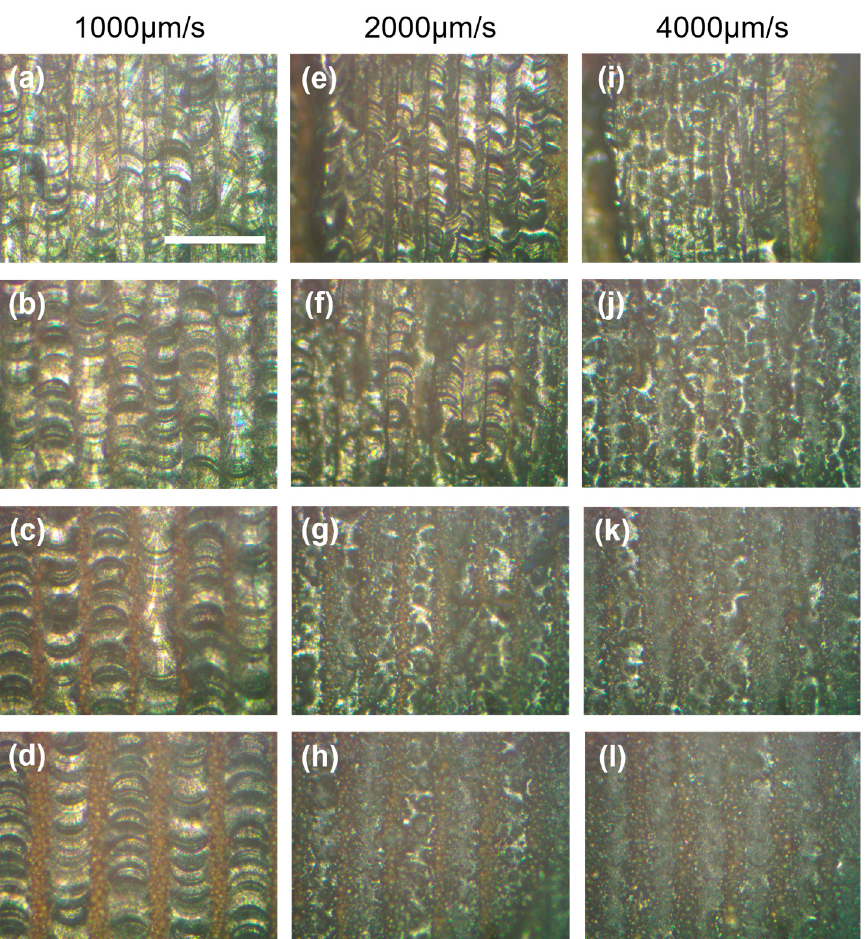
Figure 5. Effects of hatch space on the morphology revolution of single track and layer at 500 khz and 1 μ J under lack of energy mode: ( a – d ) 50 μ m, 75 μ m, 100 μ m, and 125 μ m at 1000 μ m/s in Figure 3f, ( e – h ) 30 μ m, 50 μ m, 75 μ m, and 100 μ m at 2000 μ m/s in Figure 3g, ( i – l ) 30 μ m, 50 μ m, 75 μ m, and 100 μ m at 4000 μ m/s in Figure 3h. All scale bars = 200 μ m.